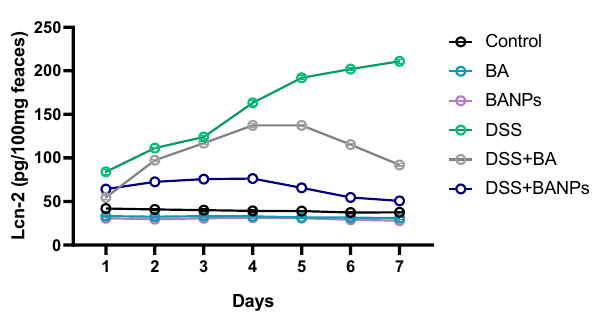
Figure 2. Effects of orally administered B. amyloliquefaciens (BA) or BA-nanoparticles (BANPs) in non- colitic and colitic rats on fecal lipocalin-2 (Lcn-2) levels 7 days post DSS induction. Non-colitic groups including Control, BA and BANPs groups where rats were orally gavaged PBS, B. amyloliquefaciens and B. amyloliquefaciens loaded nanoparticles (BA at level of 1.0 × 10 10 CFU/kg in 1 mL of PBS/rat/day), respectively, for 7 days. Colitic groups: DSS, BA and BANPs groups where rats were orally gavaged dextrane sodium sulphate (DSS), B. amyloliquefaciens + DSS and B. amyloliquefaciens loaded nanoparticles (BA at level of 1.0 × 10 10 CFU/ kg in 1 mL of PBS/rat/day) + DSS , respectively, for 7 days. All groups orally gavaged by 5% DSS. Values are expressed as mean ± SE, a,b,c Means of the bars with different letters were significantly different among groups ( P <